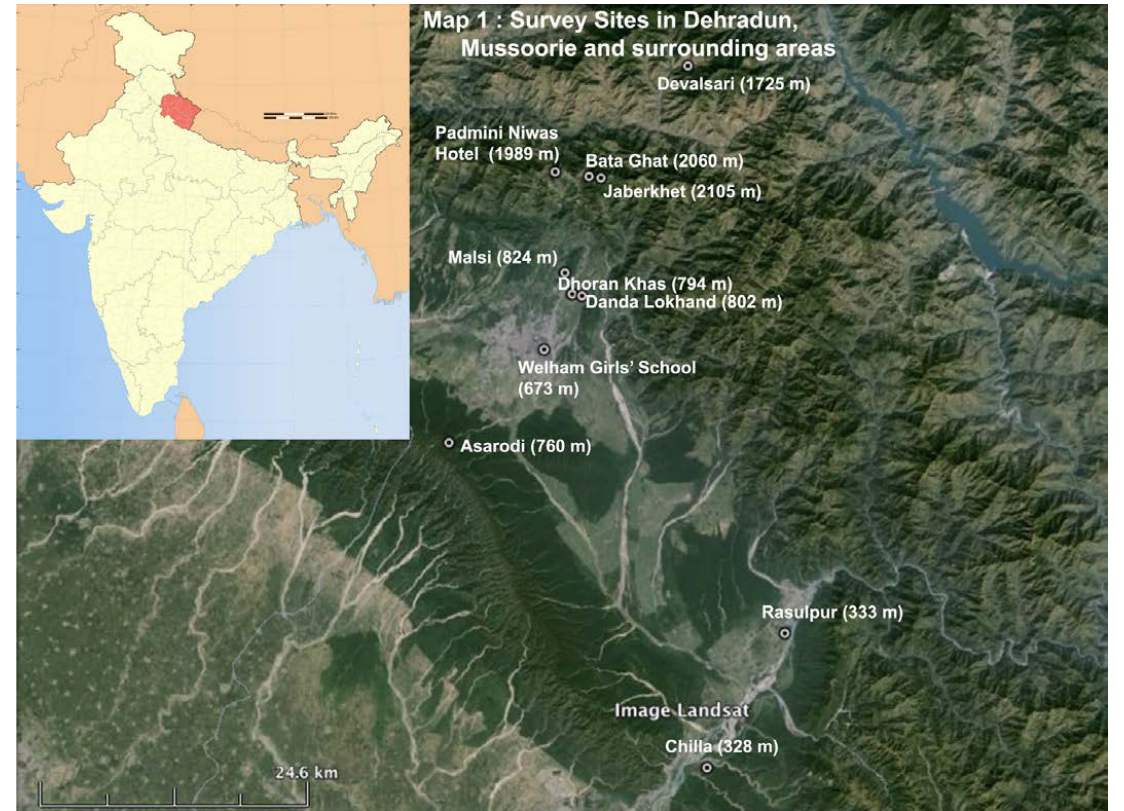
Figure 1. Study sites and surrounding